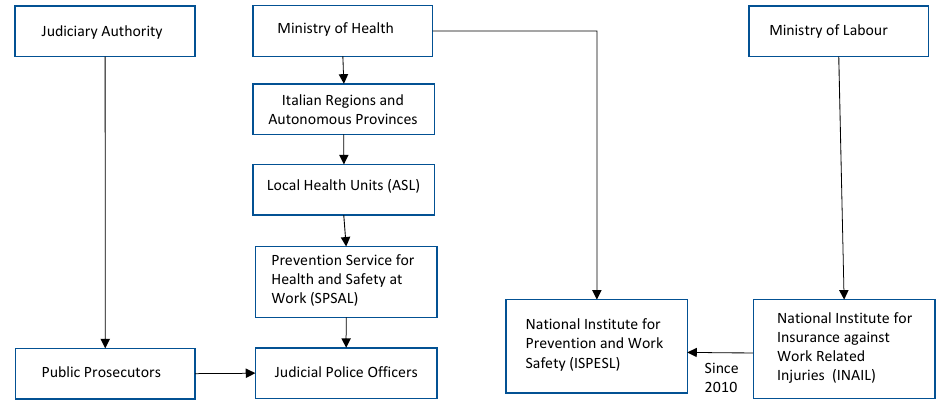
Figure 1. Judicial System, Departments of the Italian Government and Local Occupational Health and Safety Authorities (Hierarchical level: Higher → Lower).